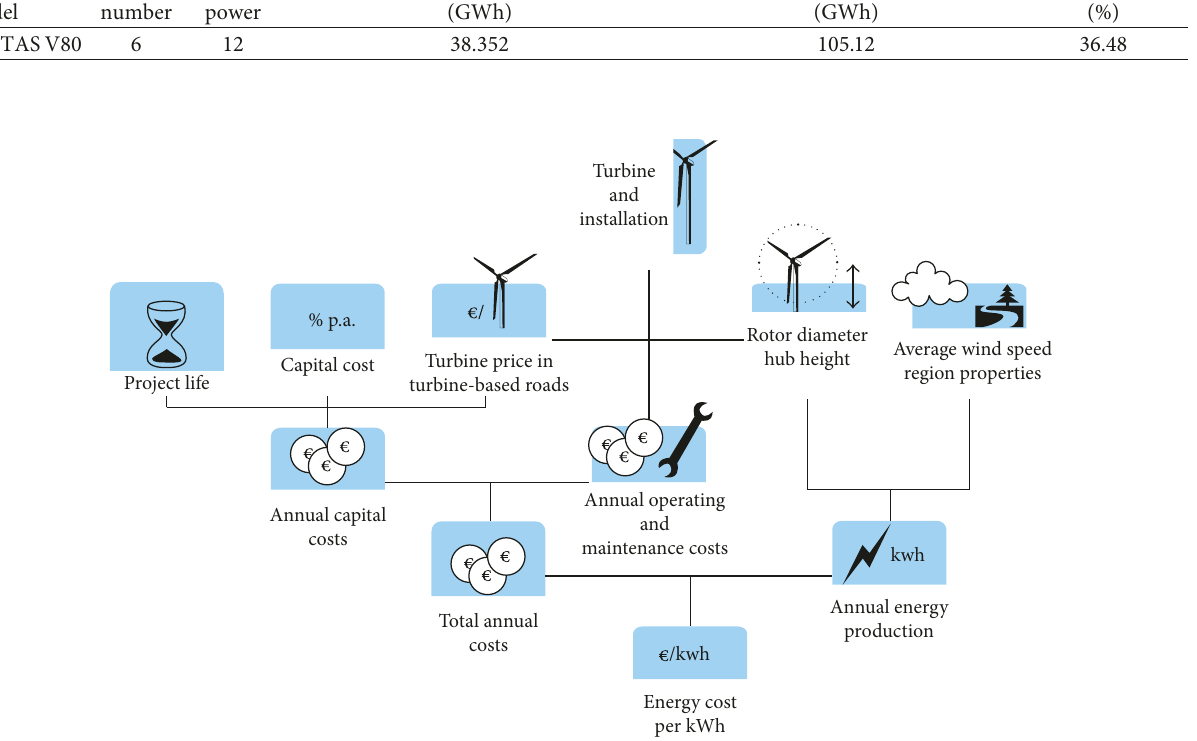
Figure 9: Cost structure per kWh for wind power projects.